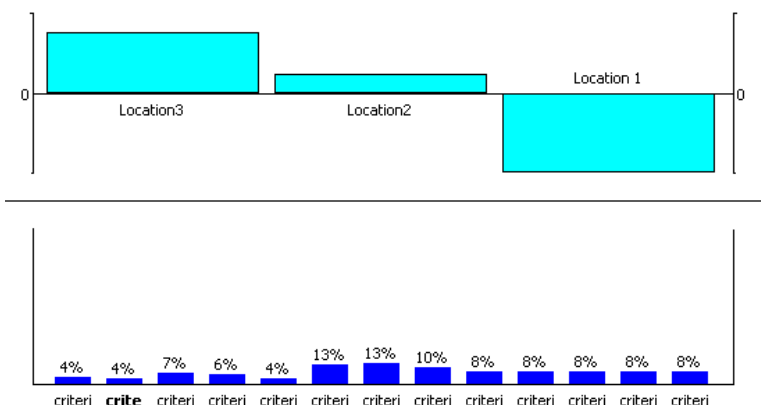
Figure 5. Final ranking of investment solutions and fine-tuned criteria weights.